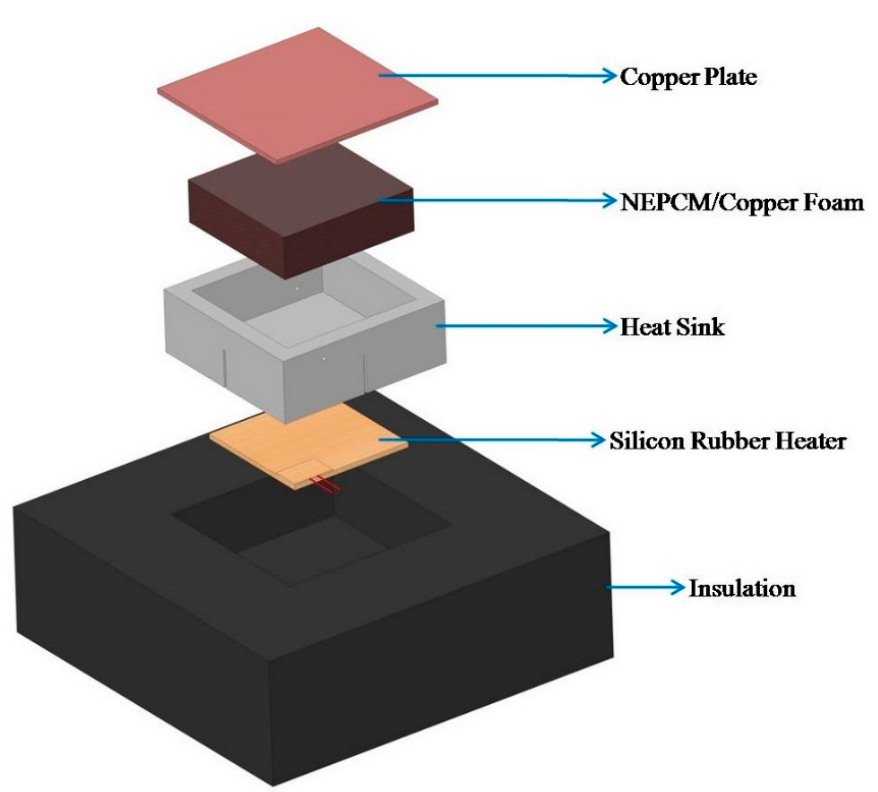
Figure 3. Exploded view of heat sink assembly.